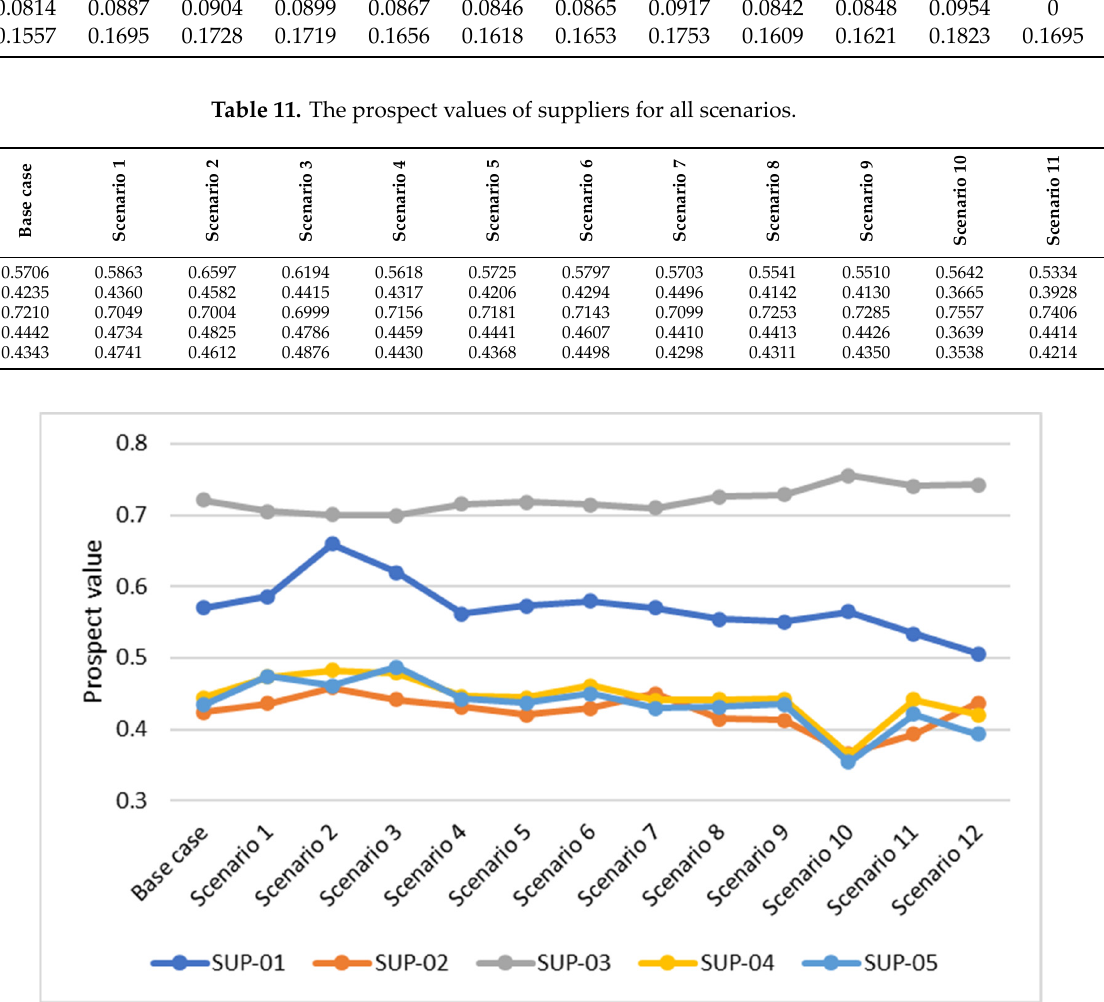
Table 11. The prospect values of suppliers for all scenarios.